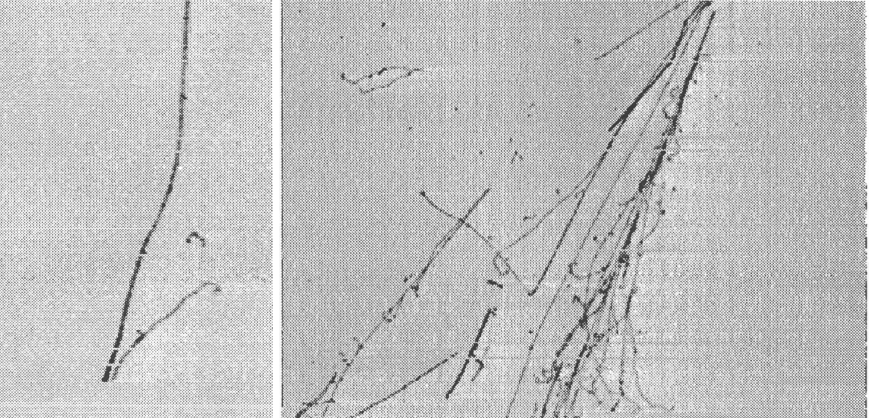
Figure 3. ( Left ): Stopping muon and subsequent decay electron track. The size of the image is ∼ 40 × 40 cm 2 . The gap between the muon and the electron track is due to the 3 µ s muon lifetime. ( Right ): Cosmic ray-induced